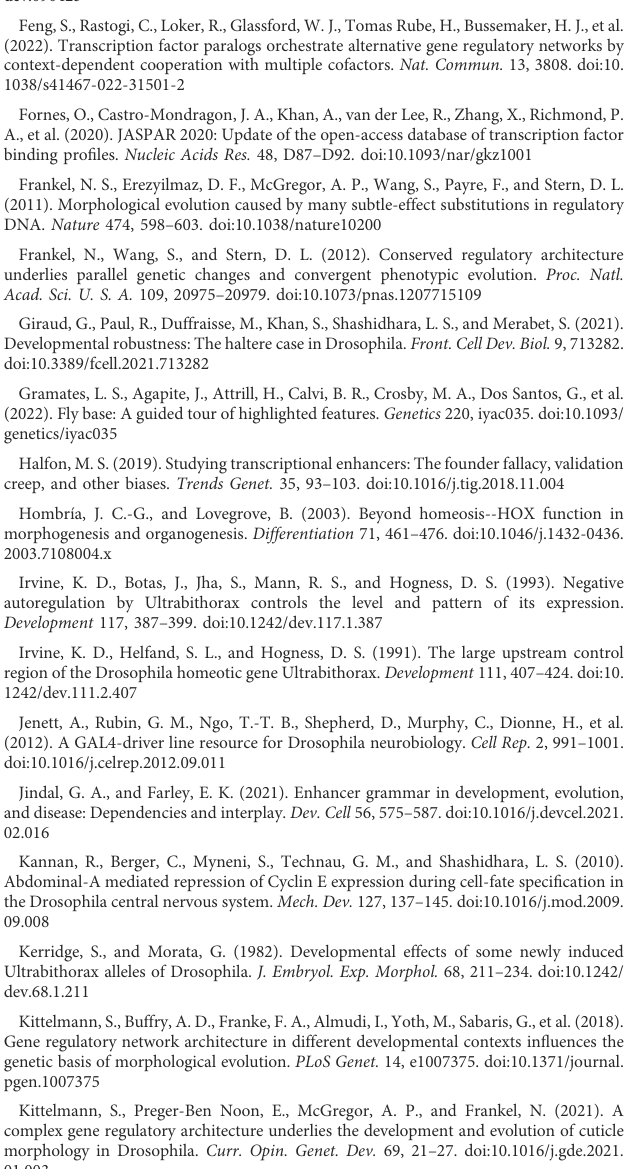
SUPPLEMENTARY MATERIAL S4 (DATA SHEET 4) Raw measurements of NV from all RNAi experiments including statistical signi fi